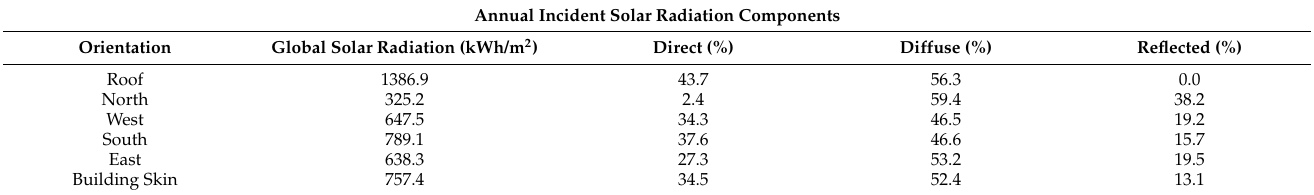
Table 4. Annual incident solar radiation and daylight illuminance on building skins with the contribution of each component.